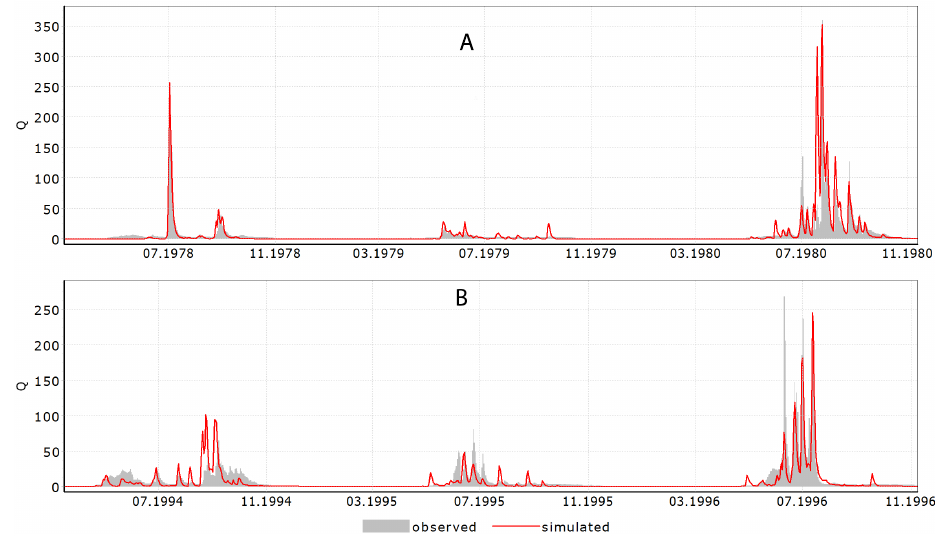
Figure 5. Observed and simulated hydrographs for the Amalat River at Ust’-Antose with “stationary” parameters: (a) average (1978), dry (1979) and wet (1980) years, (b) negative (1994), mean (1995) and high (1996) Nash-Sutcliffe value.